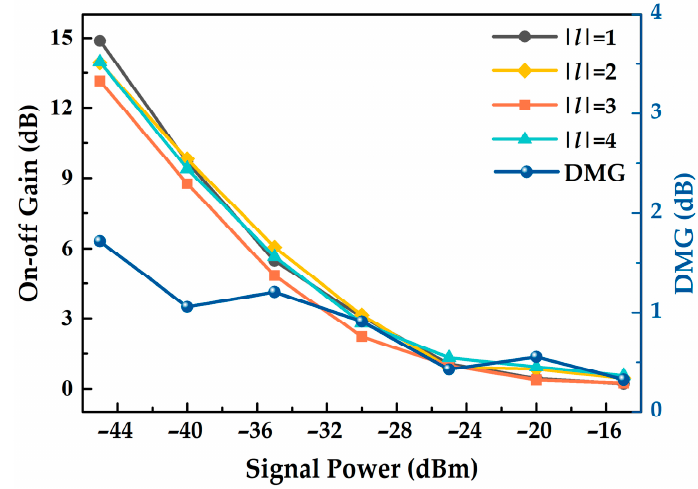
Figure 8. The OAM mode on–off gain and DMG versus signal power.